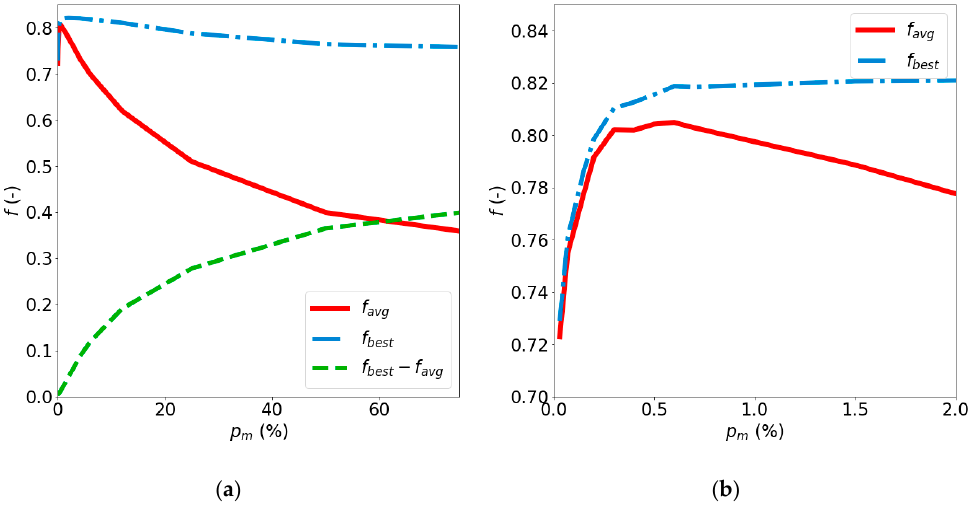
Figure 14. Result of the sensitivity study of the fitness to the mutation rate. In ( a ) the whole research space has been plotted and ( b ) only the mutation rate between 0 and 2% has been plotted.